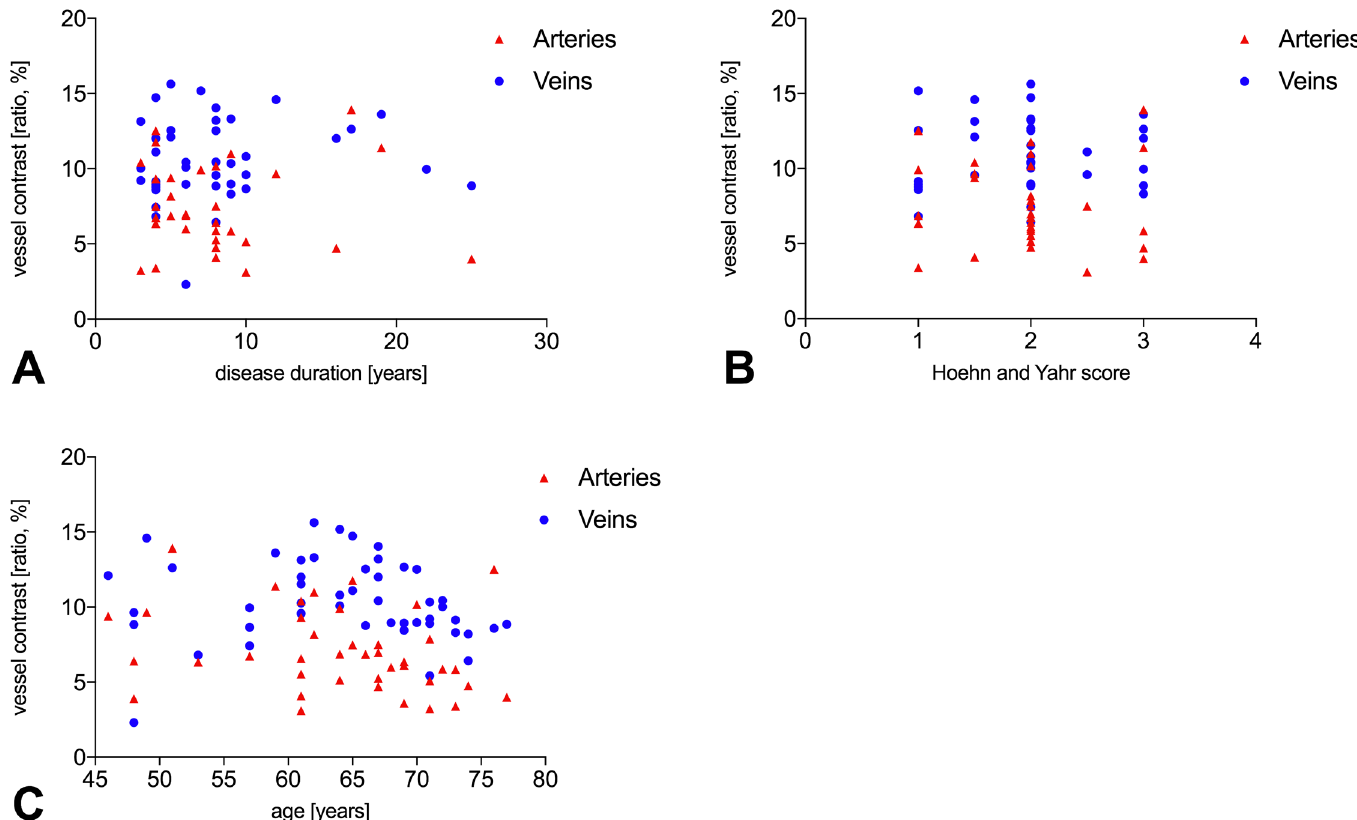
Fig 4. Correlation of the vessel contrast change in patients with PD with parameters of disease progression and age. (A) Disease duration did not correlate with the vessel contrast ( p -value > 0.05). (B) The clinical progression chart Hoehn and Yahr did not correlate with the vessel contrast ( p -value > 0.05). (C) The age of the patients did not correlate with the vessel contrast ( p -value >